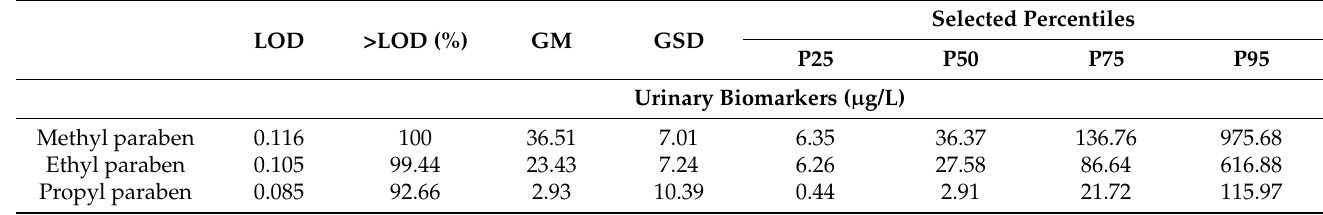
Table 2. Distribution of parabens concentrations ( µ g/L) in maternal blood.